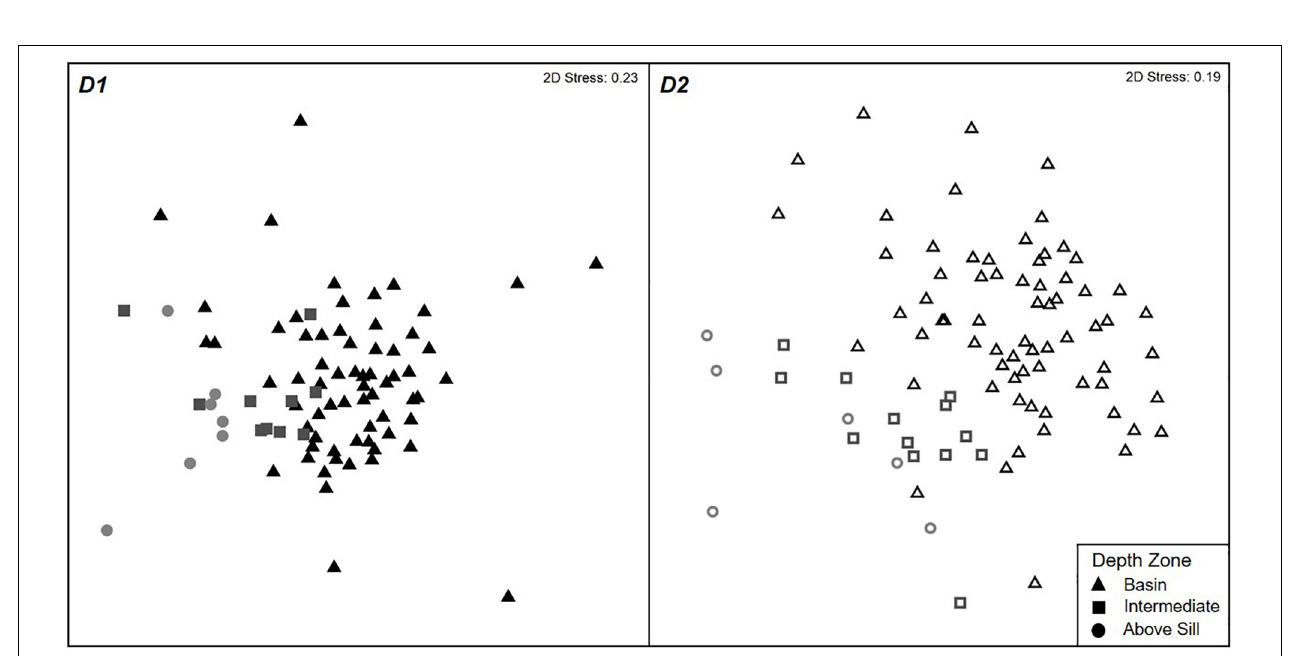
FIGURE 4 | Example of taxa and megafauna communities observed in Sognefjord, Norway. Panels (a–g) represents Basin Zone taxa on exposed hard substrate. Panels (h–m) displays Basin taxa in environments with both hard and soft substrate present. Panels (n–r) shows taxa common in soft sediment habitats. Panels (s–u) displays taxa within the Intermediate Zone. Panels (v–y) shows the Above Sill Zone. Refer to Table 2 for the taxa identifications.